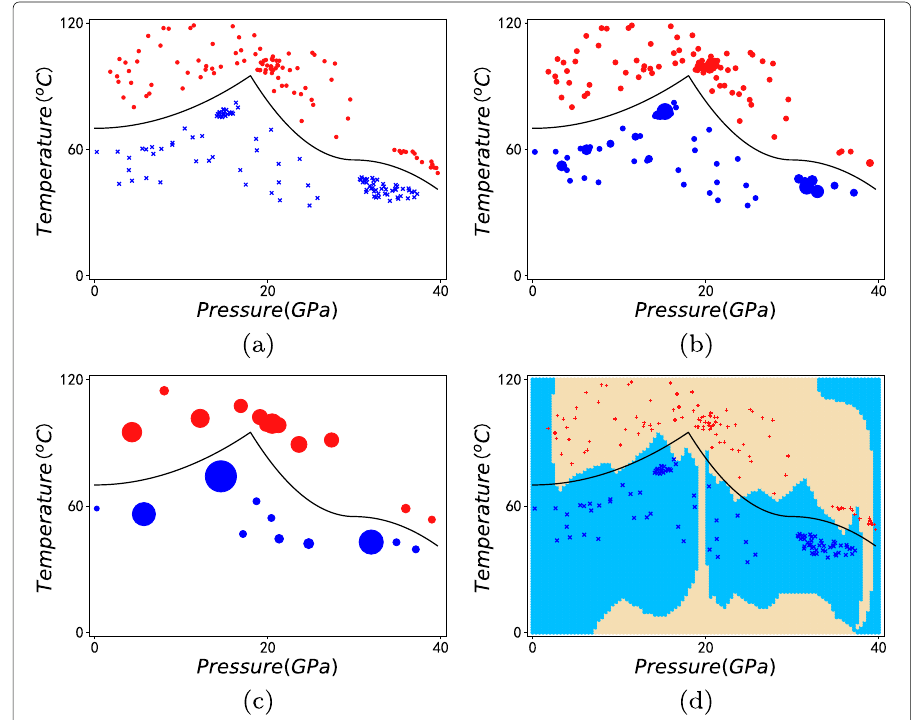
Fig. 3 Classification of metallic and insulating states of VO 2 : a Initial data used for classification. Red dots represent metallic state, and blue ones represent insulating state. Phase transition line indicated by the black solid curve. b Forming subgroups after applying algorithm[S1] once. Similarly in ( b ) and ( c ), blue or red spheres are used to represent data with the same sublabel, where the center of sphere represents the average vector, and the radius represents number of vectors belong to this sublabel. c Results after repeating algorithm[S2,S3] 3 times. d Prediction of new data. New vector in the blue part will be recognized with label ‘insulating’, and label of new vectors in yellow part will be predicted as ‘metallic’. Blue and red dots are still the initial